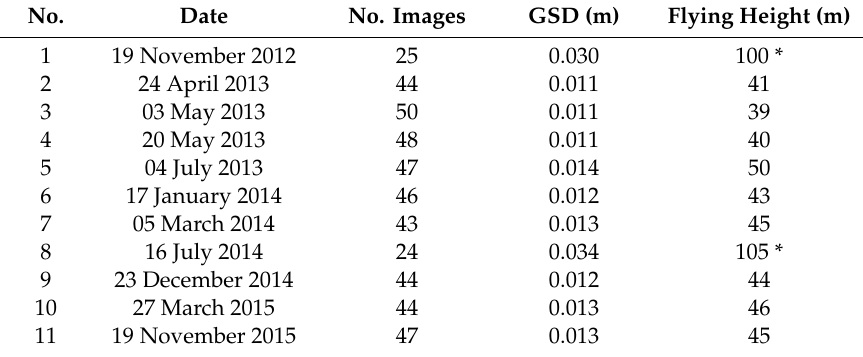
Table 1. Properties of photogrammetric flights.